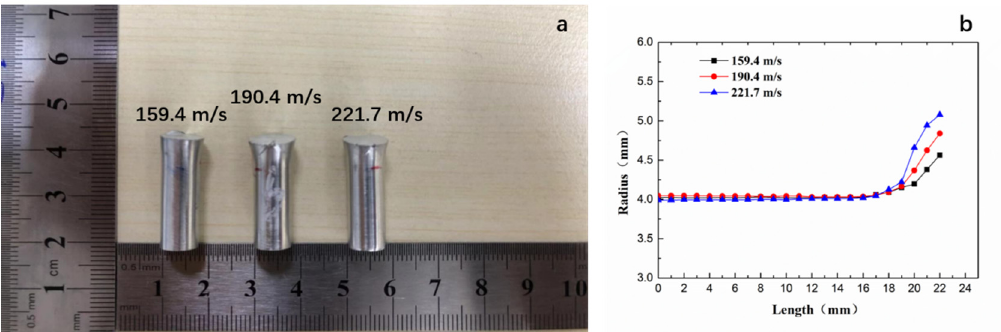
Figure 7. ( a , b ) the shape and the silhouettes of the specimens at different impact velocities.